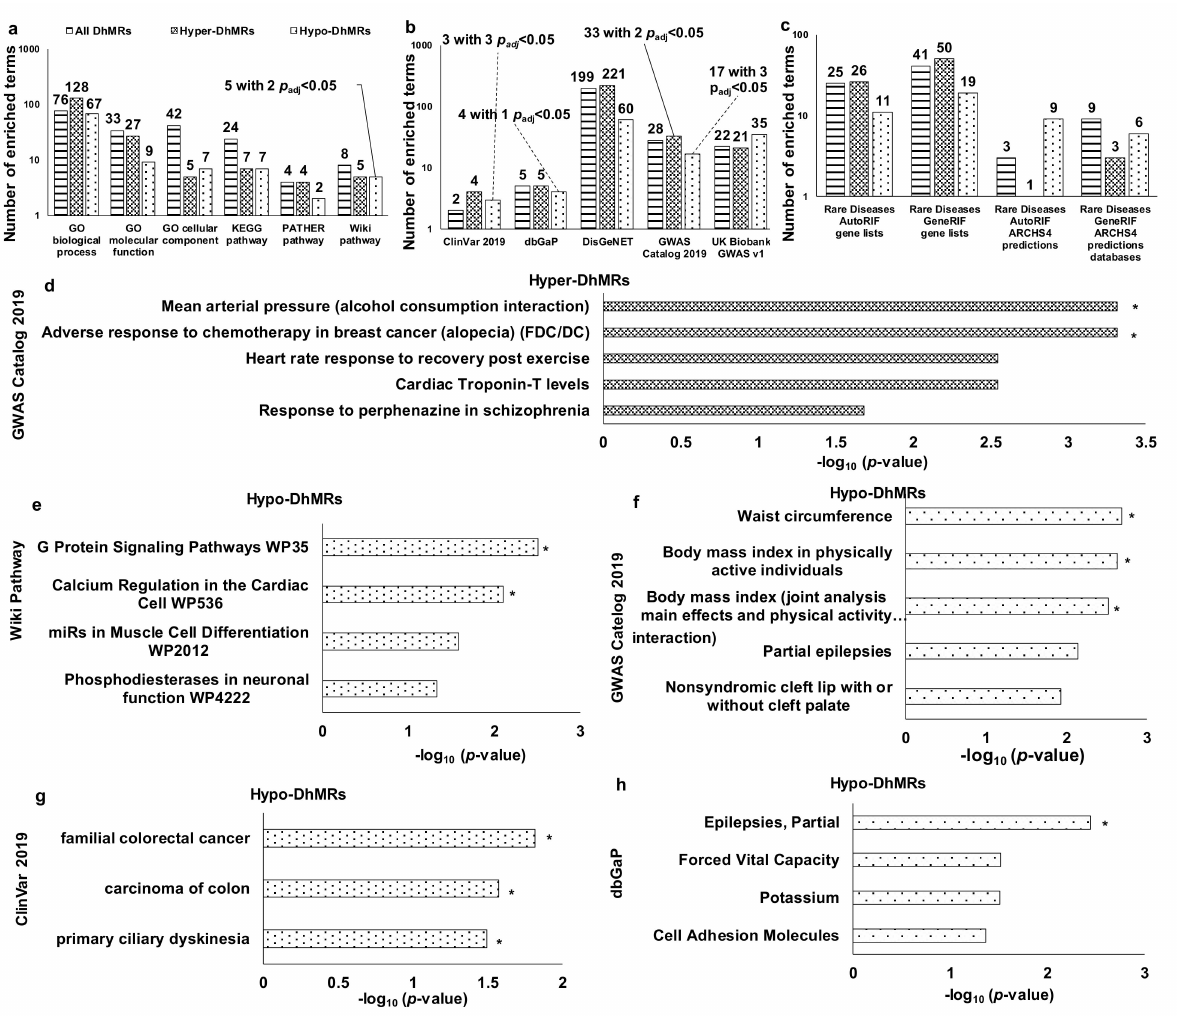
Figure 3. Biological functions and pathways, phenotypes, disorders, and (rare) diseases apparently relevant to males. ( a ) The number of enriched terms for biological functions and pathways ( p < 0.05); ( b ) the number of enriched terms for phenotypes, disorders, diseases and rare diseases ( p < 0.05); ( c ) the number of enriched terms for rare diseases ( p < 0.05); ( d – h ) up to top 5 enriched terms with the smallest nominal p -values < 0.05 for the top terms containing any terms with p adj < 0.05. * p adj : multiple-testing adjusted p -value using the Benjamini-Hochberg False Discovery Rate (FDR)